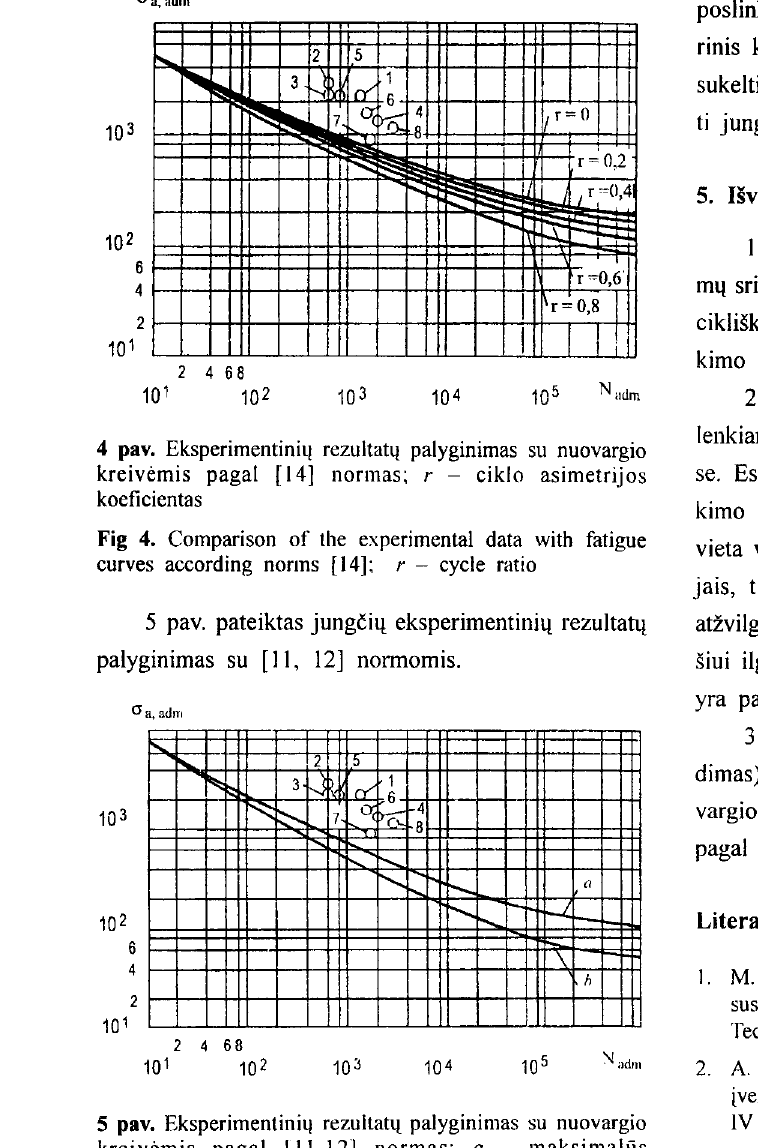
Fig 5. Comparison of the experimental data with fatigue curves according to norms [II, 12]: a - max nominal stress 0,9 a y ; b - max nominal stress a y 4 paveiksle pateiktas srieginitt jungCiq M48x4 eksperimentinitt rezultat4_ pagal plysio atsiradimct pa lyginimas su skaiciuojamosiomis nuovargio kreivi:mis pagal [ 14]